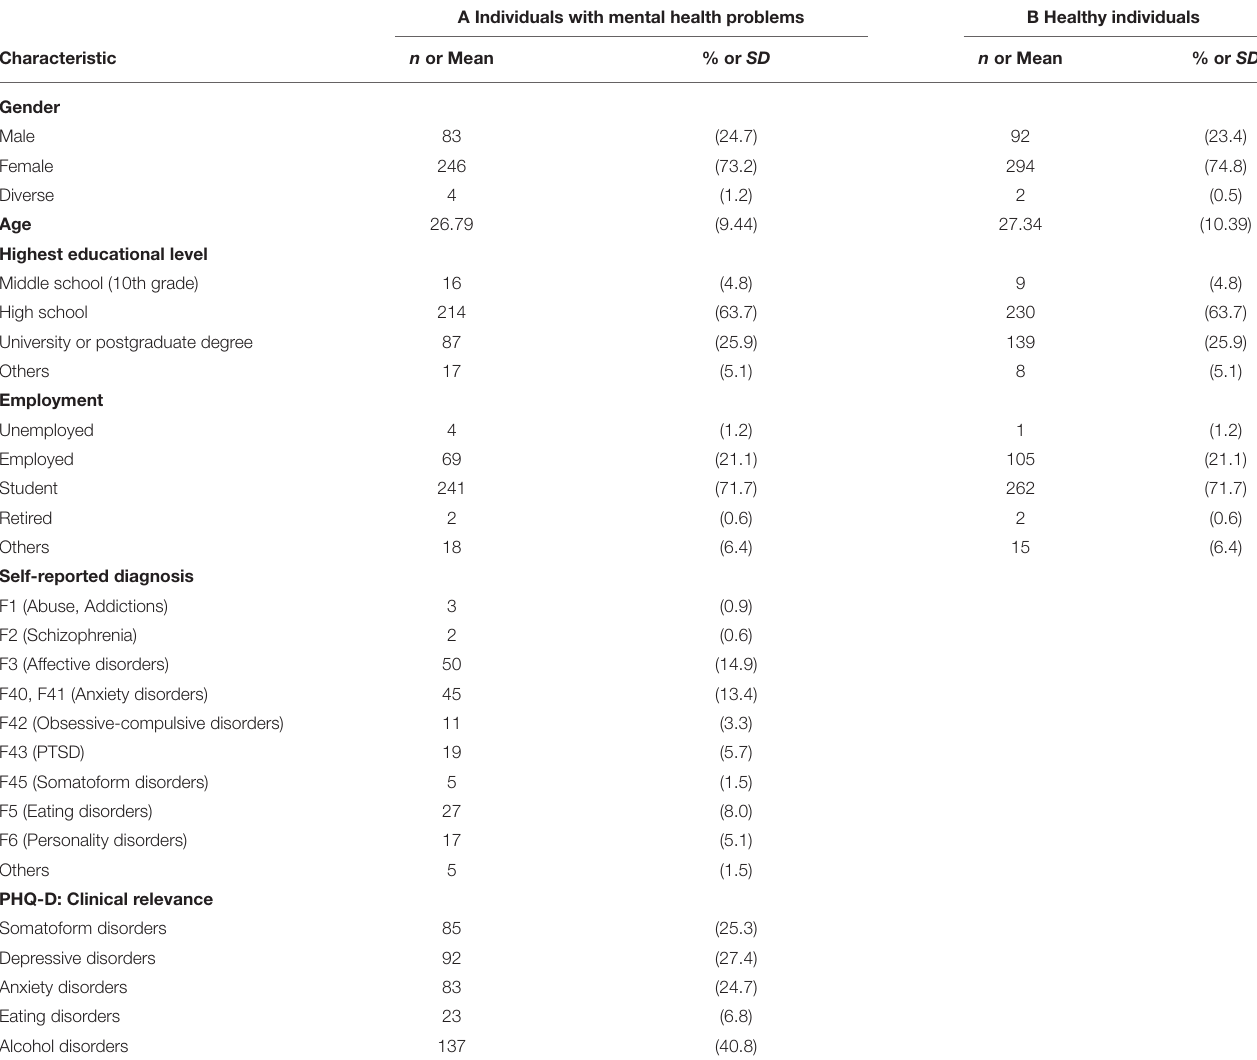
TABLE 1 | Sociodemographic and clinical characteristics of the subsamples A ( n = 336) and B ( n =